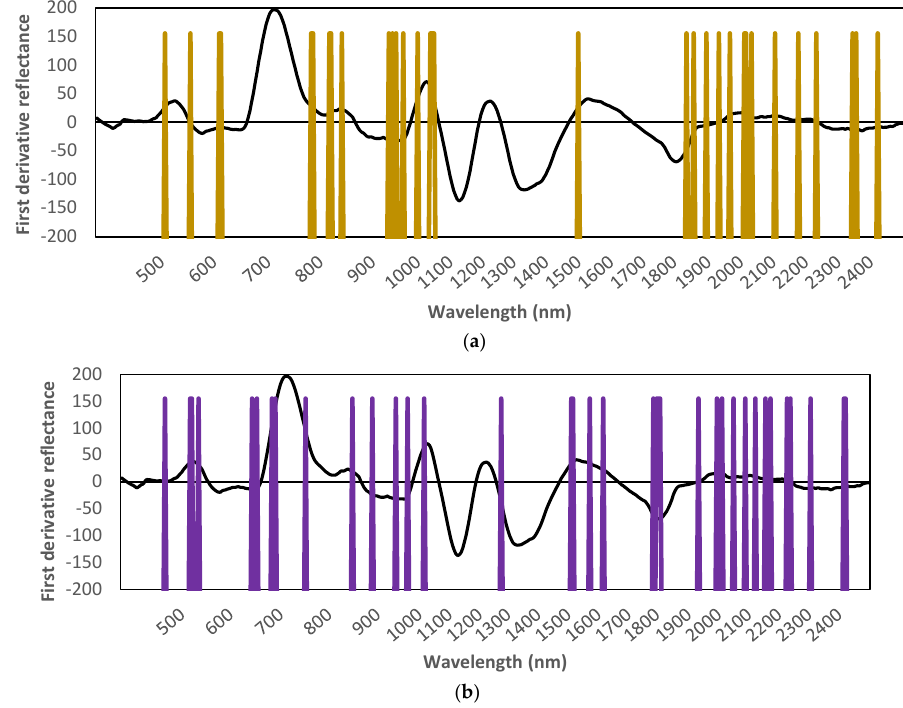
Figure 5. Important wavelengths selected using recursive feature selection-random forest regression for ( a ) crude protein (CP) ( b ) metabolizable energy (ME).